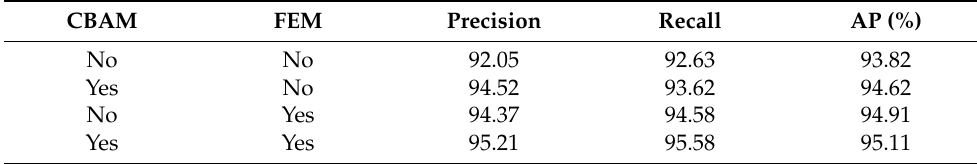
Table 12. Ablation experiments and